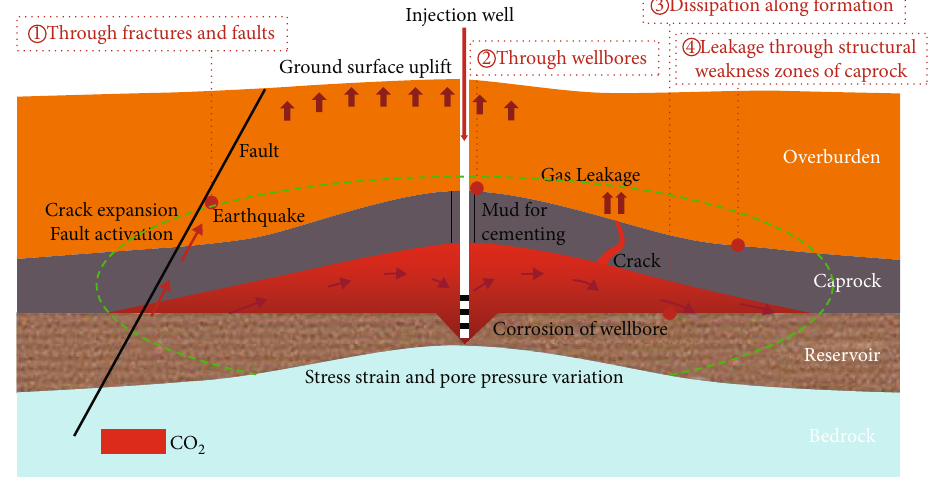
Figure 1: Schematic of mechanical problems caused by CO